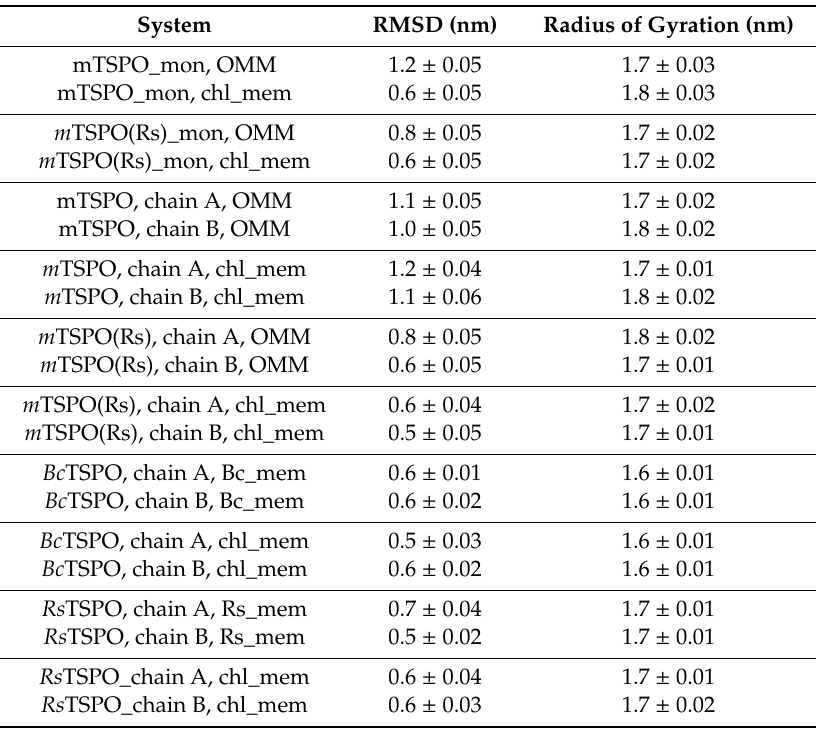
Table 2. Root mean square deviation (RMSD) and radii of gyration values of the systems investigated here, averaged over the equilibrated trajectories (namely the last 6 µ s for mouse monomeric and dimeric systems and 1.3 µ s for the bacterial